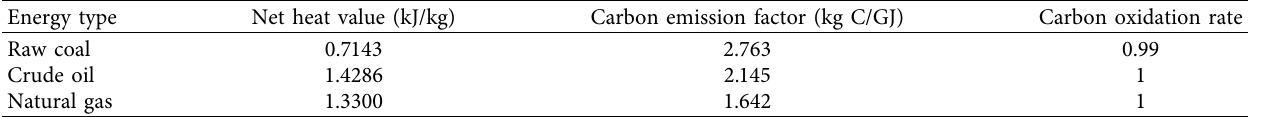
Table 3: Coefficients of different energy.